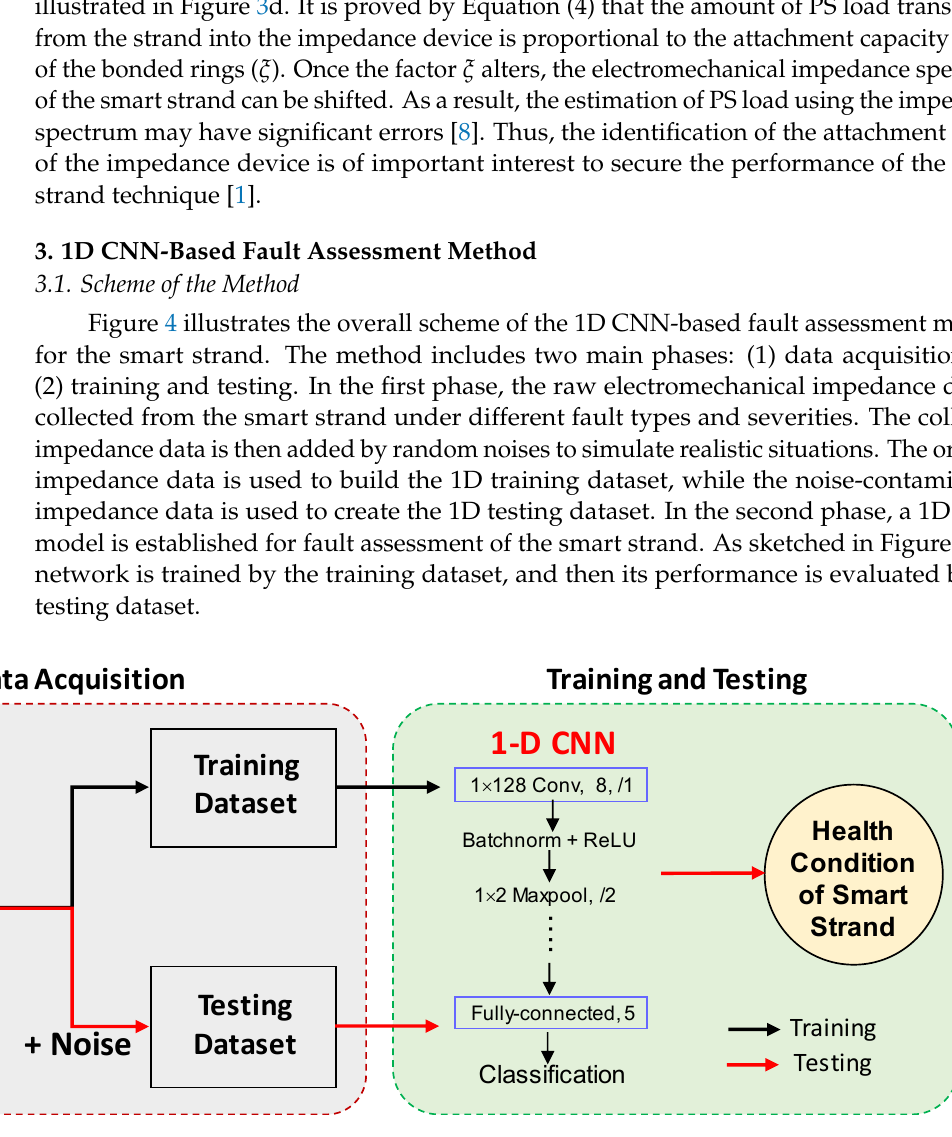
Figure 4. The 1D CNN ‐ based fault detection method for the smart strand.